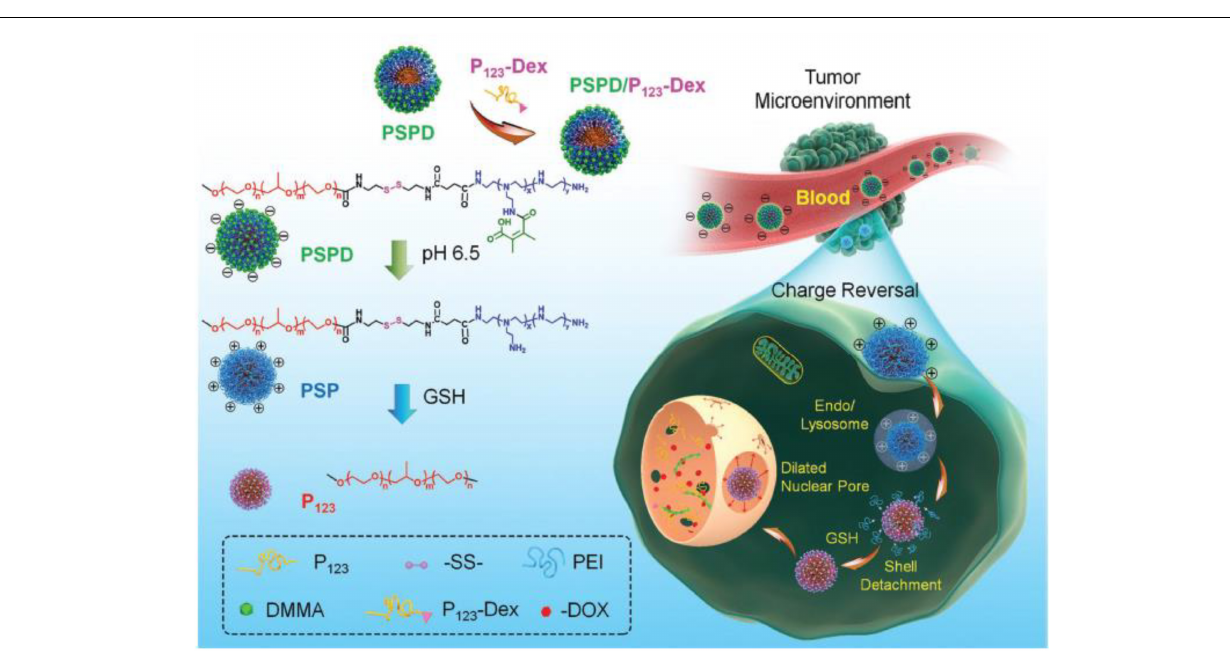
were used as the corona material. The degradation of disulfide bonds as linker between poly lactide and polyethylenimine was triggered by intracellular glutathione, resulting in the